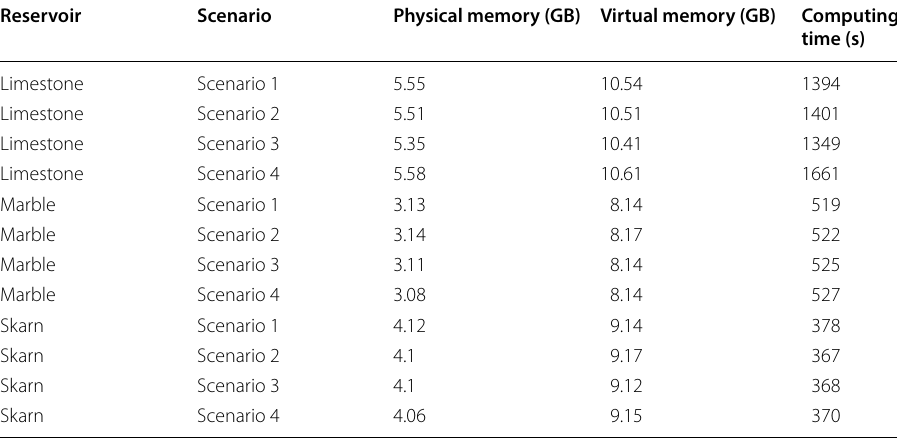
Table 5 Computational physical and virtual memories and computation time